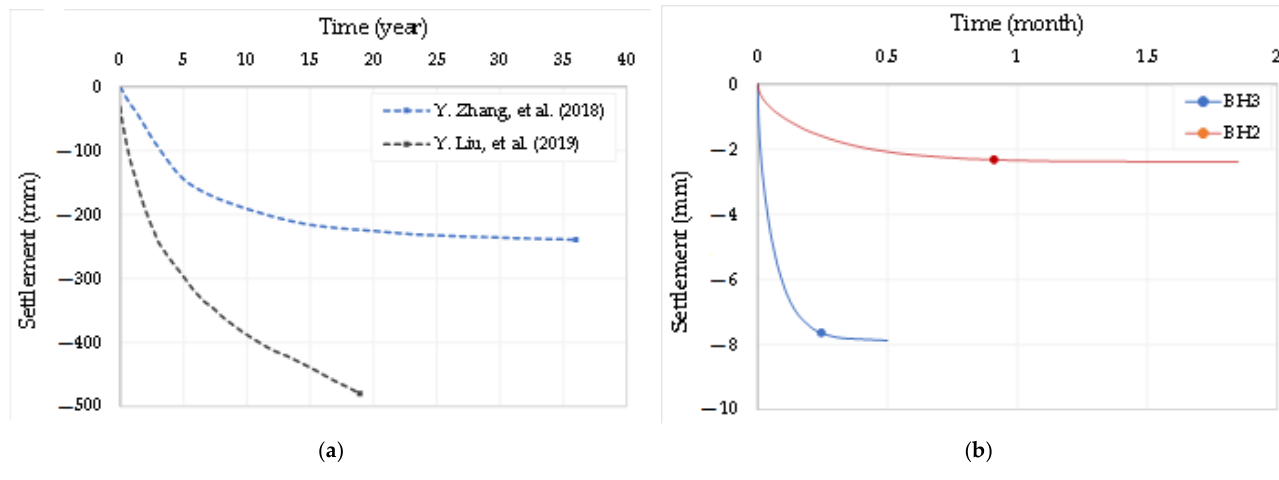
Figure 13. Comparison of sediment settlement in the previous study on the river delta by Y. Zhang, et al. (2018) and Y. Liu, et al. (2019) ( a ) and present study at BH2 and BH3 ( b ).